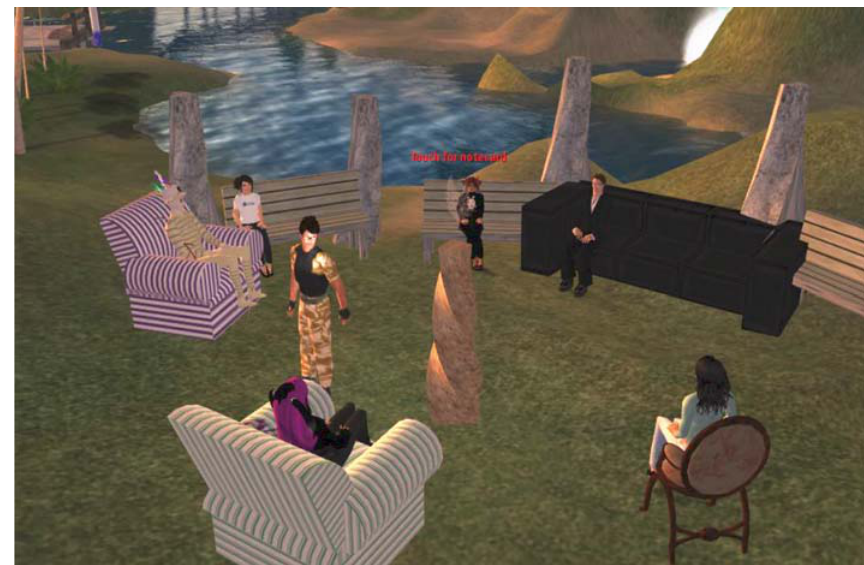
Figure 2. The space adapted by participants. Linden Research,